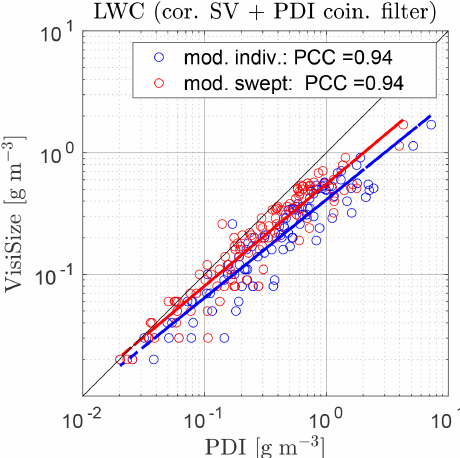
Figure 16. Comparison of the LWC results between the VisiSize and the PDI probe after adjusting the DNCs from the PDI using the reciprocal fit ( y = a ; see Fig. 10). The data are shown after x + b correction of the SV, applying the coincidence filter to the PDI re- sults, and D min cutoff to both instruments’ data. Each PDI method for the LWC computation is shown with a different color within the plot (each pair of blue and red circles: a selected measurement of ∼ 15min). Dashed blue/red lines show the LSR, and the PCCs are displayed in the